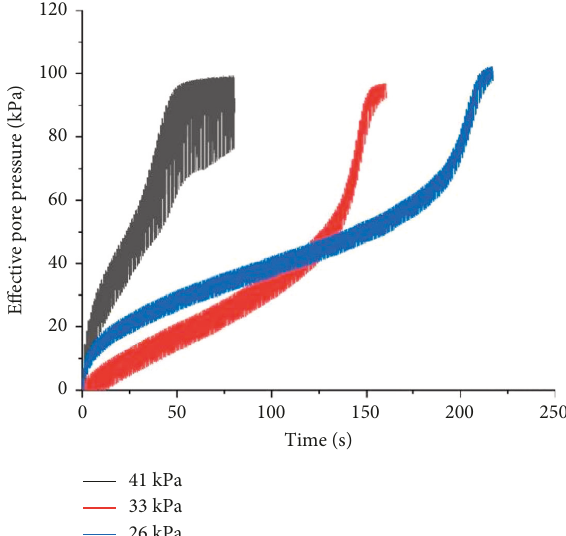
Figure 7: Effective stress path curve of standard sand